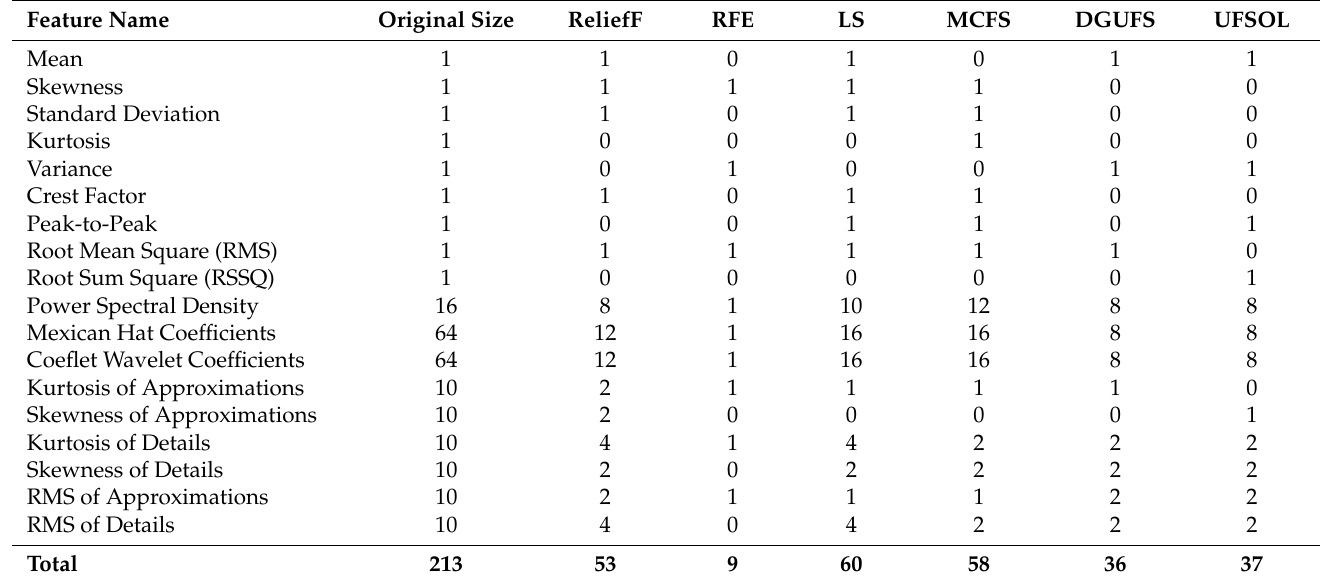
Table 3. List of Features and Comparison of Feature Selection